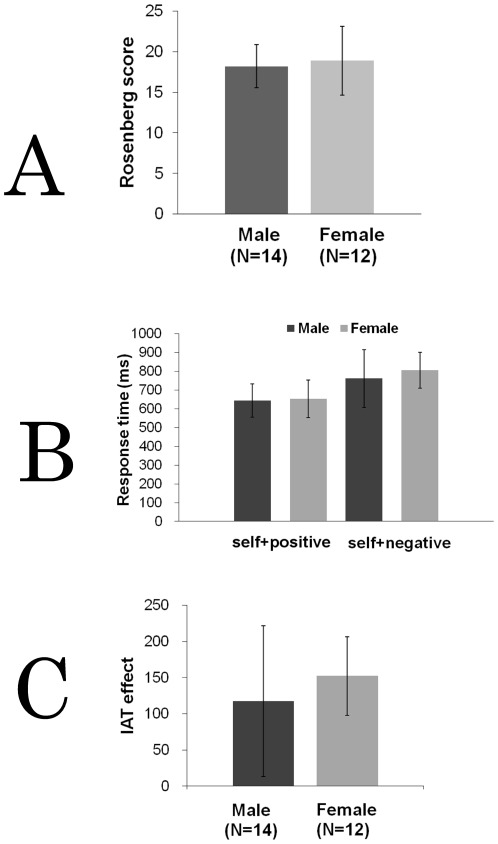
Comparisons of Rosenberg scores, response times in IAT, and IAT effects in males and females.(A) Rosenberg self-esteem scores in males and females. There was no significant gender difference. (B) Response times for each main condition in IAT. (C) The mean IAT scores in males and females. There was no gender difference in the IAT scores. Error bars indicate standard error.